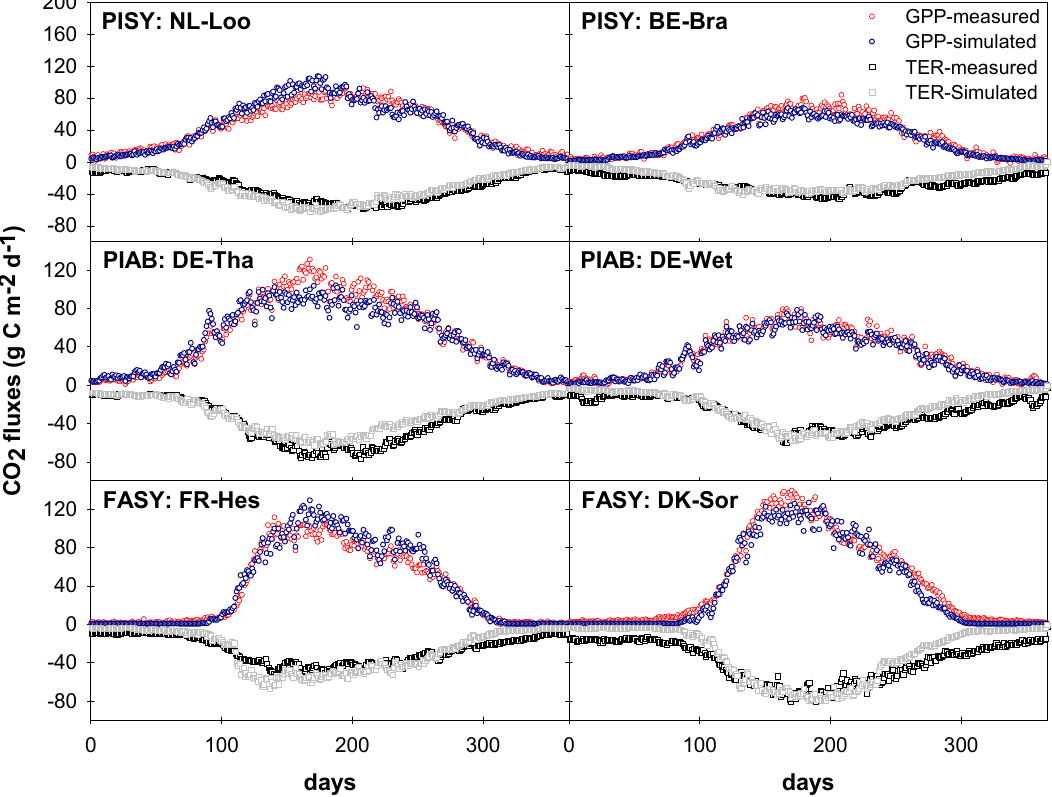
Figure 5. Inter-daily mean for Gross Primary Production (GPP) and Net Ecosystem Exchange (NEE) obtained with site-specific parameters at stands with different model performances (best left site, worst right site). Daily mean values are calculated throughout the evaluation period (see Table 6 for details). PISY: Pinus sylvestris , PIAB = Picea abies , FASY = Fagus sylvatica